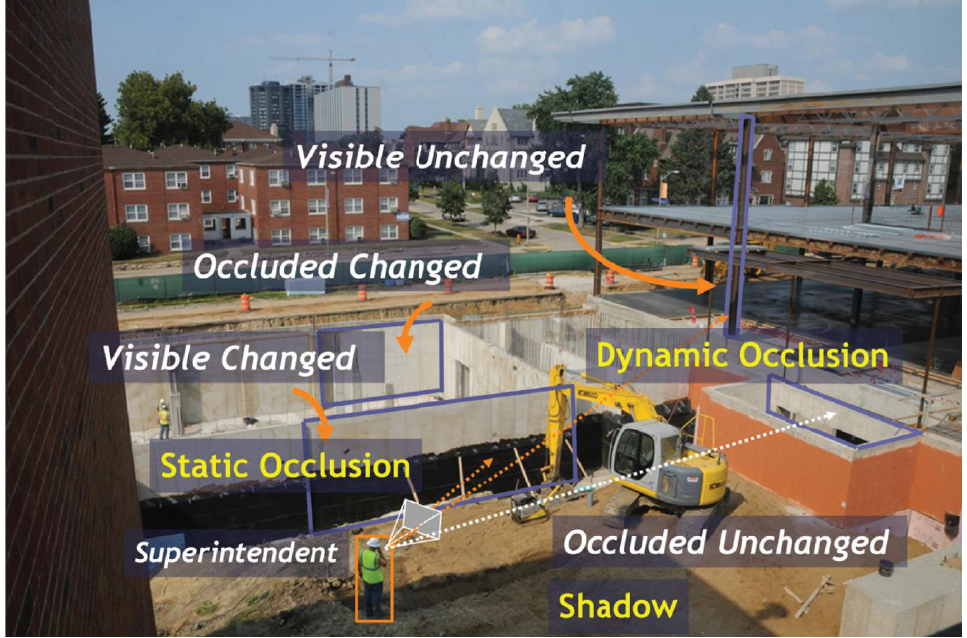
Figure 9. Occlusions